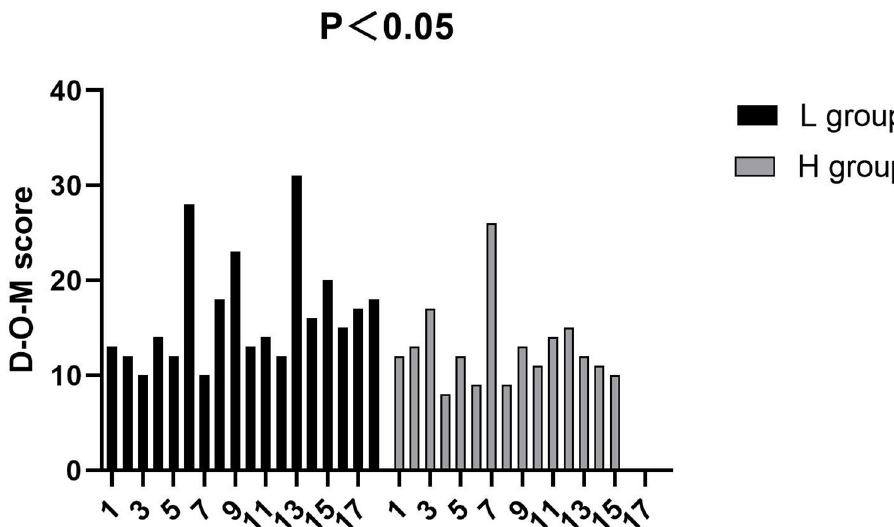
Fig 3. The D-O-M scores of the first episode of delirium of the two groups.